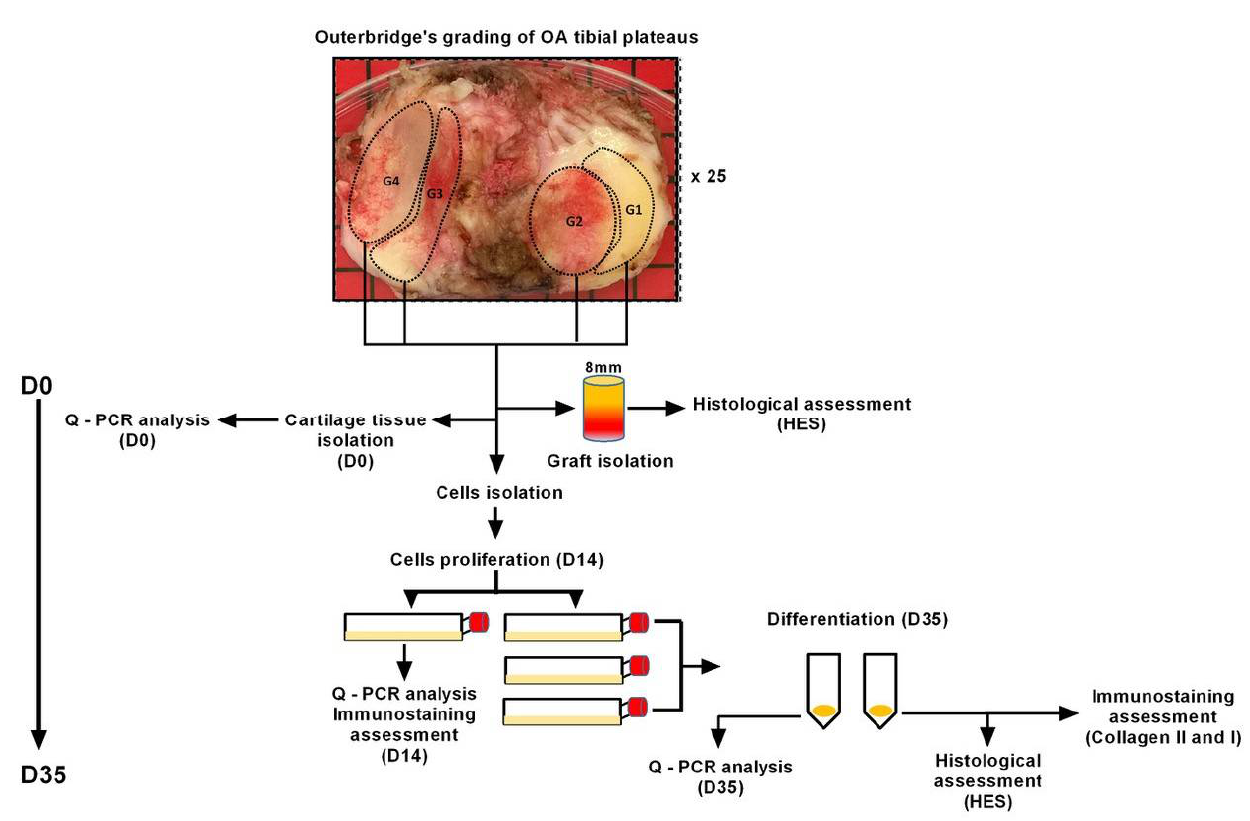
Figure 1. Schematic illustration of experimental design. First the macroscopic Outerbridge classification of OA was used to divide the specimens into different zones. (Grade 1/G1: minimal cartilage degradation; Grade 2/G2: partial-thickness defect with fissures on the surface; Grade 3/G3: fissures to the level of subchondral bone and Grade 4/G3: loss of cartilage and exposure of subchondral bone). Each grade was further subdivided into three portions; portion 1 for isolation of the cartilage tissue (D0-qPCR), portion 2 for histology and OARSI grade examination and portion 3 for isolation of cells from cartilage tissue, their expansion (D14-qPCR) and re-differentiation (D35-qPCR, histology and immunostaining).